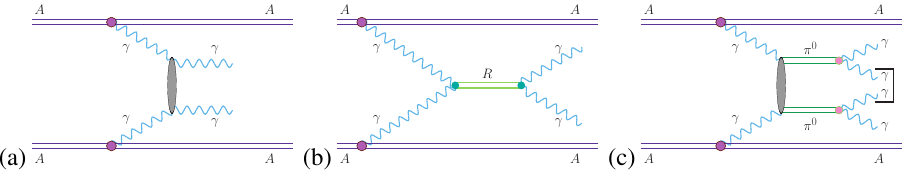
Figure 1. The continuum γγ → γγ scattering (a) which includes box diagrams with leptons and quarks only [3]. Panel (b) shows diagram for s -channel γγ → pseudoscalar / scalar / tensor resonances which contribute to the γγ → γγ process. Diagram (c) presents background related to the γγ → π 0 π 0 subprocess when only one photon from each π 0 → γγ decay is